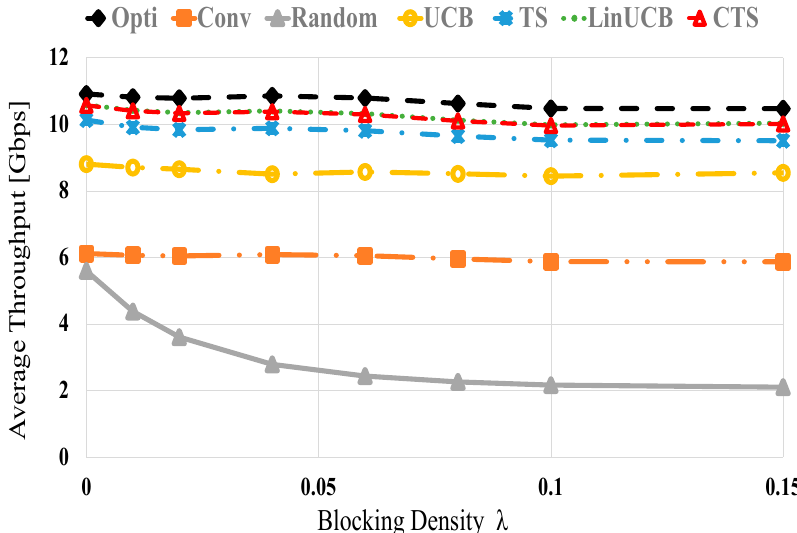
Figure 4. Average throughput versus blocking density λ for UCB, TS, LinUCB, and CTS algorithms using 60 devices.